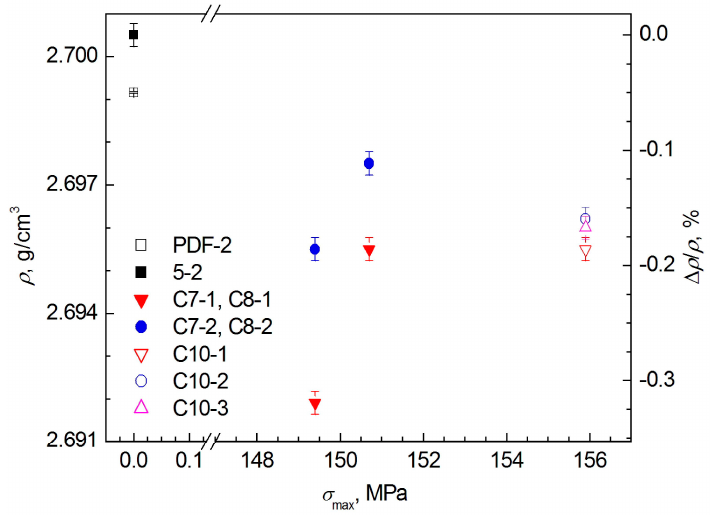
Figure 2. Integral mass density ρ of samples according to densitometric measurements depending on the maximum load σ max of cyclic fatigue tests. The density defect ∆ ρ / ρ was calculated taking the integral density of the initial sample 5-2 as ρ 0 to calculate the difference Δ ρ = ρ − ρ 0 . The value indicated as PDF-2 in the Figure corresponds to the data by [24], Powder Diffraction File-2 (PDF-2) [25] card 01-071-4008 at a temperature T = 298 K close to the room temperature of densitometric measurements. Compared to the initial state (sample 5-2), the value of the decrease in mass density ∆ ρ / ρ for the samples C7-1 and C8-1 cut from the regions of wires near the fracture was − 0.32(1)% and − 0.19(1)%, respectively, and − 0.19(1)% and − 0.11(1)%, correspondingly, for samples C7-2 and C8-2 from the regions far from the